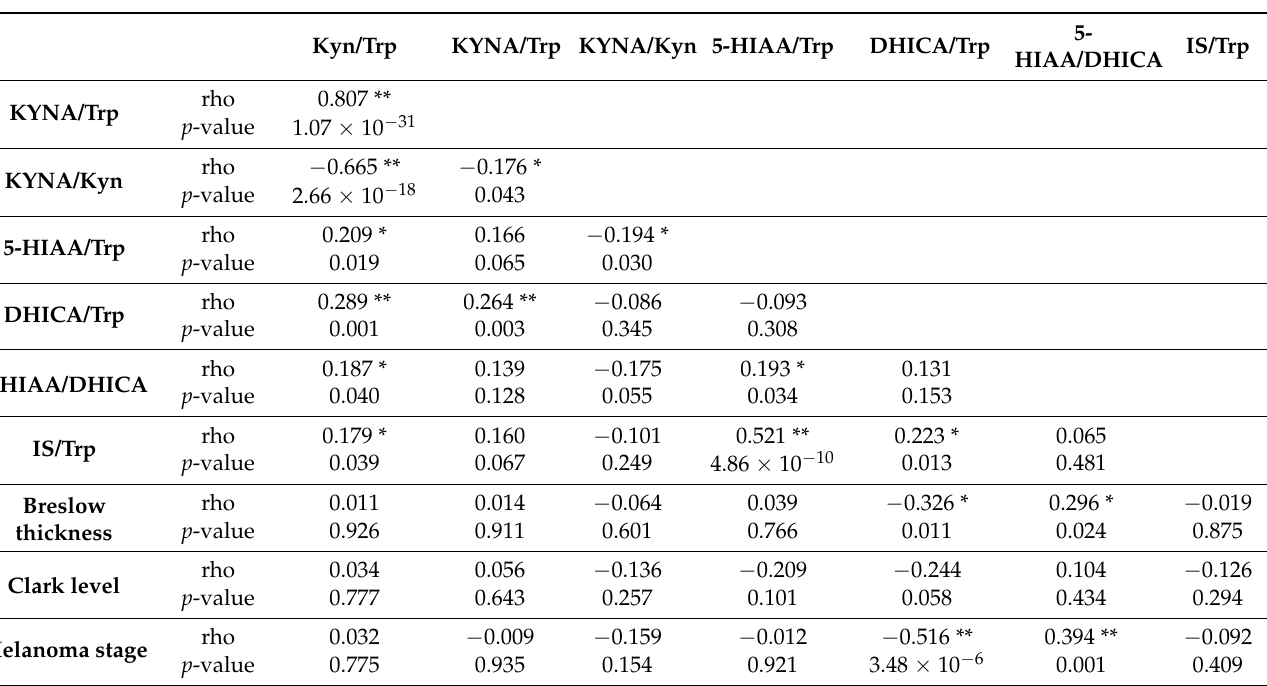
Table 6. Nonparametric correlation between the ratios of the studied parameters, the Breslow thickness, Clark level, and the melanoma